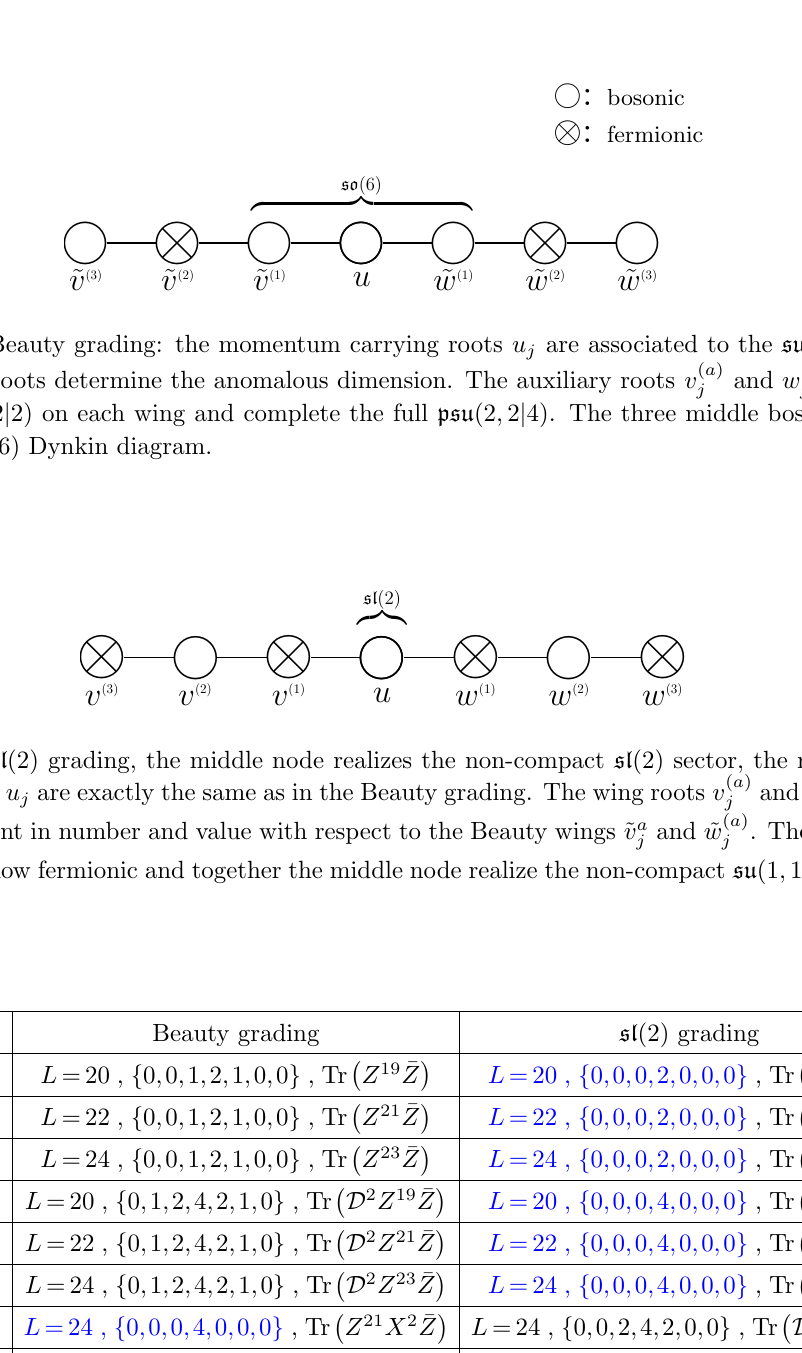
Table 7 . The 8 Super-Classes labelled by the length L of the spin chain , the seven occupation number of the nodes in the Dynkin diagram and the (cid:12)eld content in terms of scalars and light-cone derivatives gradings. The Super-Classes are ordered according to the di(cid:14)culty to (cid:12)nd their correspondent Bethe solutions. We highlight in blue the descriptions with the minimun number of